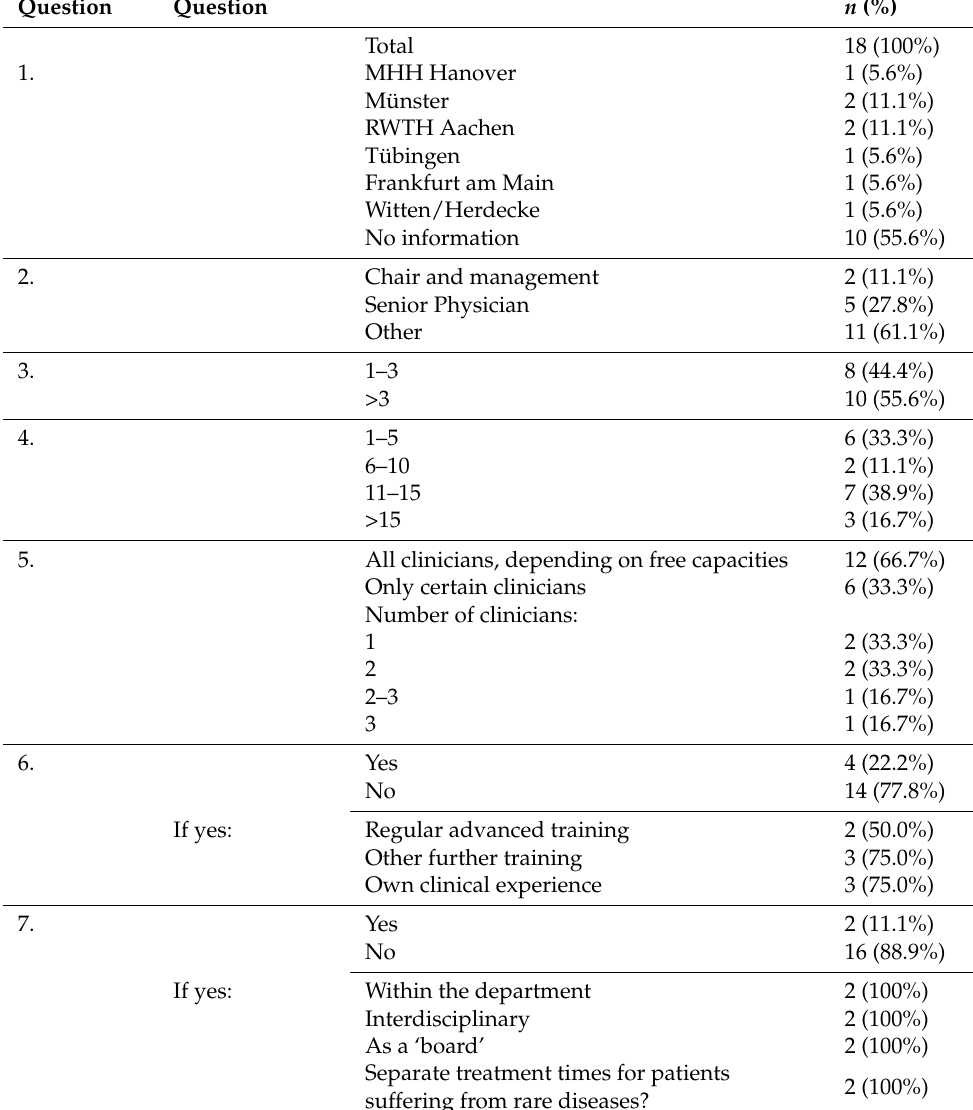
Table 6. Questions on the